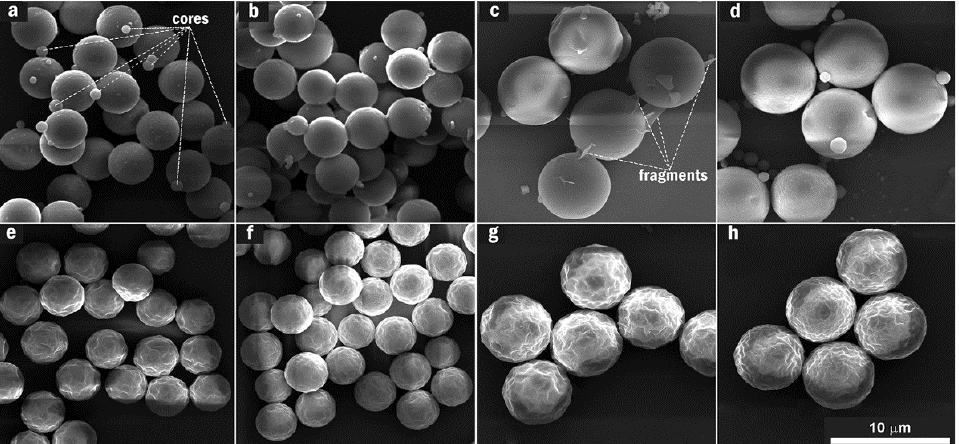
Figure 1. Impact of the acid-treatment reaction on MF n microsphere SEM images: ( a ) MF 2 , ( b ) MF 3 , ( c ) MF 6 and ( d ) MF 9 at the top were collected on non-treated microspheres from a synthetic reaction at a pH of 4.0 and 65 °C for 20 min only; meanwhile ( e ) MF 2 , ( f ) MF 3 , ( g ) MF 6 and ( h ) MF 9 at the bottom were collected on the microspheres treated in an acetic acid solution at a pH of 4.0 and 60 °C for 20 min. The MF n microsphere surfaces had been transformed into shrinkage textures while the resin cores and fragments had all been cleaned up in the acid-treatment reaction.